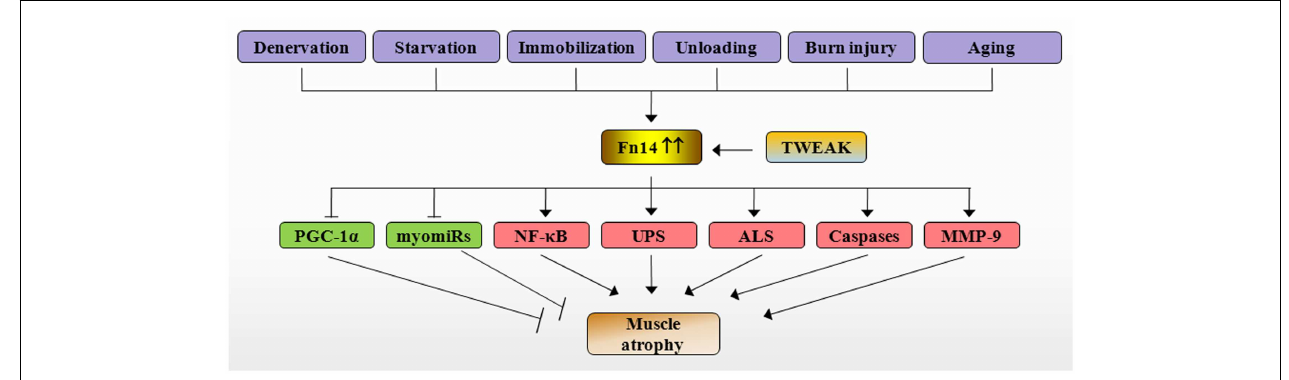
MMP-9, which eventually cause loss of skeletal muscle mass. Fn14, fibroblast growth factor inducible 14;TWEAK,TNF-like weak inducer of apoptosis; PGC-1 α , peroxisome proliferator-activated receptor-gamma coactivator 1 α ; MMP-9, matrix metalloproteinase-9; NF- κ B, nuclear factor-kappa B; UPS, ubiquitin–proteasome system; ALS, autophagy–lysosome system; myomiRs, muscle